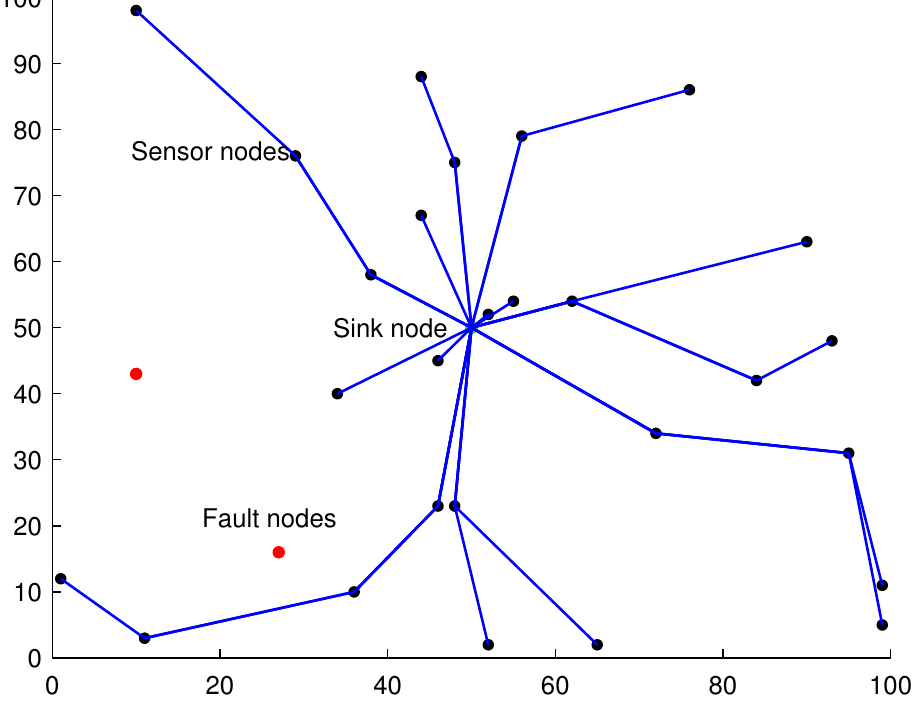
Figure 3. The topology of the network in a collection